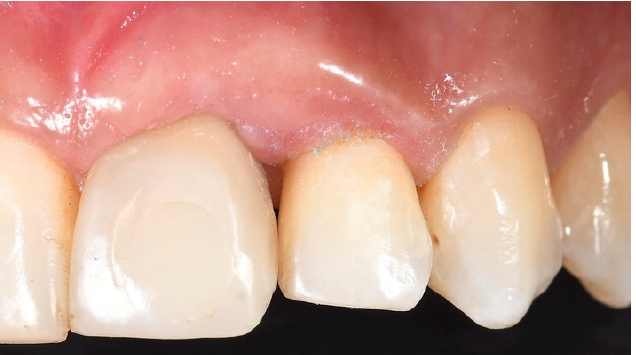
Figure 17. Soft tissue maturation and definitive restorations 9 months after CTG.